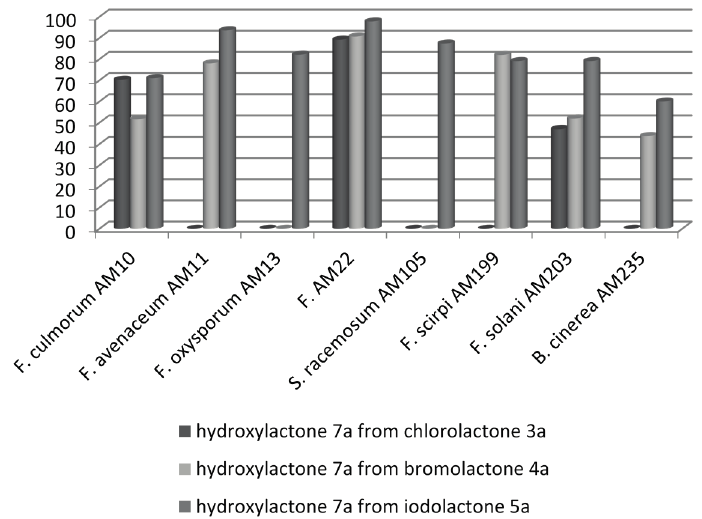
Figure 1. Results (by GC) of preparative biotransformations of lactones 3a – 5a